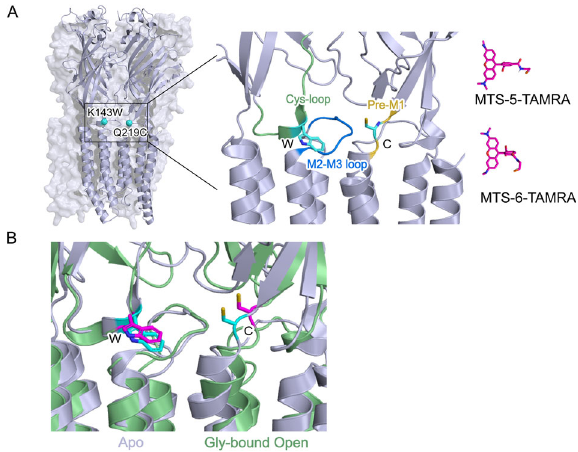
Fig. 1 | Localization of K143W/Q219C sensor in the α 1 glycine receptor struc- ture. A Side view of the zebra fi sh α 1 glycine receptor structure in Apo state (PDB:6PXD) showing the position of the mutated residues K143W in Cys-loop and Q219C in Pre-M1 loop. Right panel: representation of the two isomers of 5(6)- carboxytetramethylrhodamine methanethiosulfonate (MTS-TAMRA) used for the labeling of the mutated cysteine. B Structuralcomparisonof the quenching sensor K143W/Q219CbetweentheApostateingray(PDB:6PXD)andGly-boundopenstate in green(PBD:6PM6),residues arepresentedincyanforapostate andmagentafor Gly-bound open state. The distancecalculatedbetweentheC α of the two residues varied from 12.9 Å for the Apo state to 15.6 Å for the Open